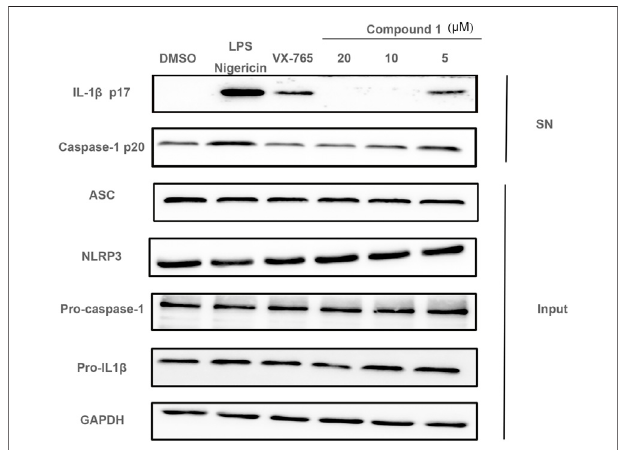
FIGURE 4 | LPS (1 μ g/ml) priming PMA-differentiated THP-1 cells were treated with various doses of compounds 1 and VX-765 (500 nM) and stimulated with nigericin (5 μ M), cell culture supernatants (SN) and cell lysate (Input) were collected. NLRP3 in fl ammasome related proteins were detected using western blot.